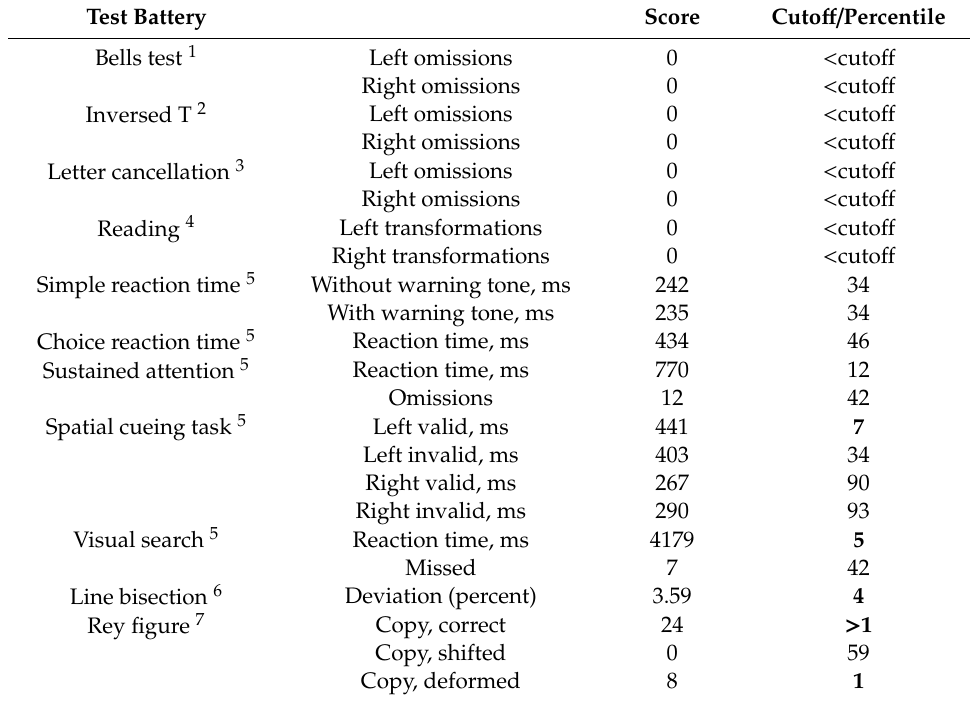
Table 1. HG’s scores in visual and visual-spatial tests.